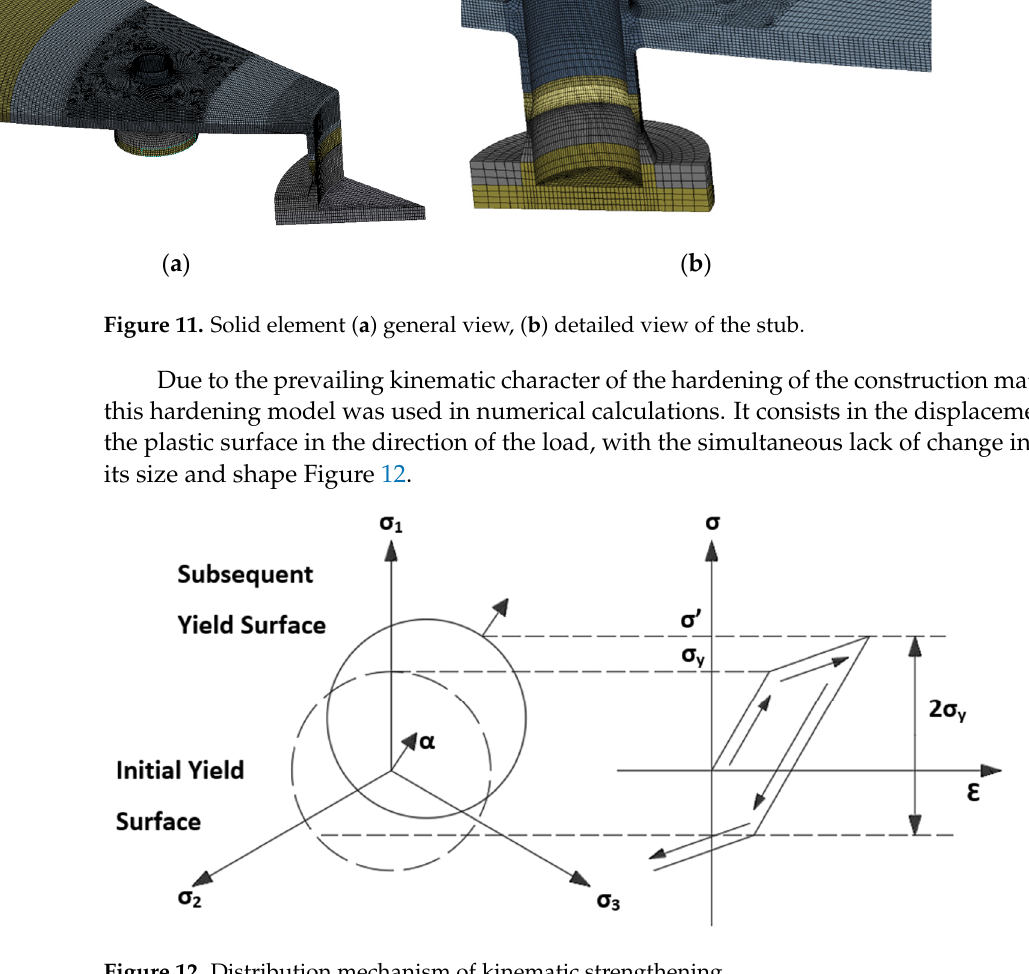
Figure 12. Distribution mechanism of kinematic strengthening.